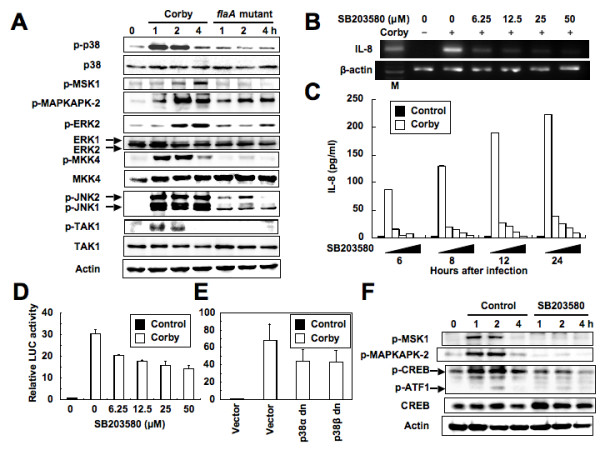
MAPKs activation by L. pneumophila through flagellin and inhibition of L. pneumophila-induced CREB and ATF1 activation and IL-8 transcription by p38 inhibitor. (A) Jurkat cells were infected with Corby or flaA mutant (MOI, 100:1), and lysates were subjected to immunoblotting. Cells were pretreated with the indicated concentrations of SB203580 for 1 h prior to infection and subsequently infected with Corby (MOI, 100:1) for 4 h (B) and for 6, 8, 12, or 24 h (C). IL-8 mRNA expression on the harvested cells was analyzed by RT-PCR (B) and the supernatants were subjected to ELISA to determine IL-8 secretion (C). (D) Cells were transfected with -133-luc and then pretreated with the indicated concentrations of SB203580 for 1 h prior to infection. They were infected subsequently with Corby for 6 h. Luciferase (LUC) activity was assayed. The solid bar indicates LUC activity of -133-luc without infection. (E) Cells were transfected with -133-luc and dominant negative mutants and then infected with Corby for 6 h. The solid bar indicates LUC activity of -133-luc without infection. All values were calculated as the change (n-fold) in induction values relative to the basal level measured in uninfected cells. Data are mean ± SD of three experiments. (F) Cells were pretreated with or without SB203580 (50 μM) for 1 h prior to infection and subsequently were infected with Corby (MOI, 100:1). Lysates were subjected to immunoblotting. dn, dominant negative.